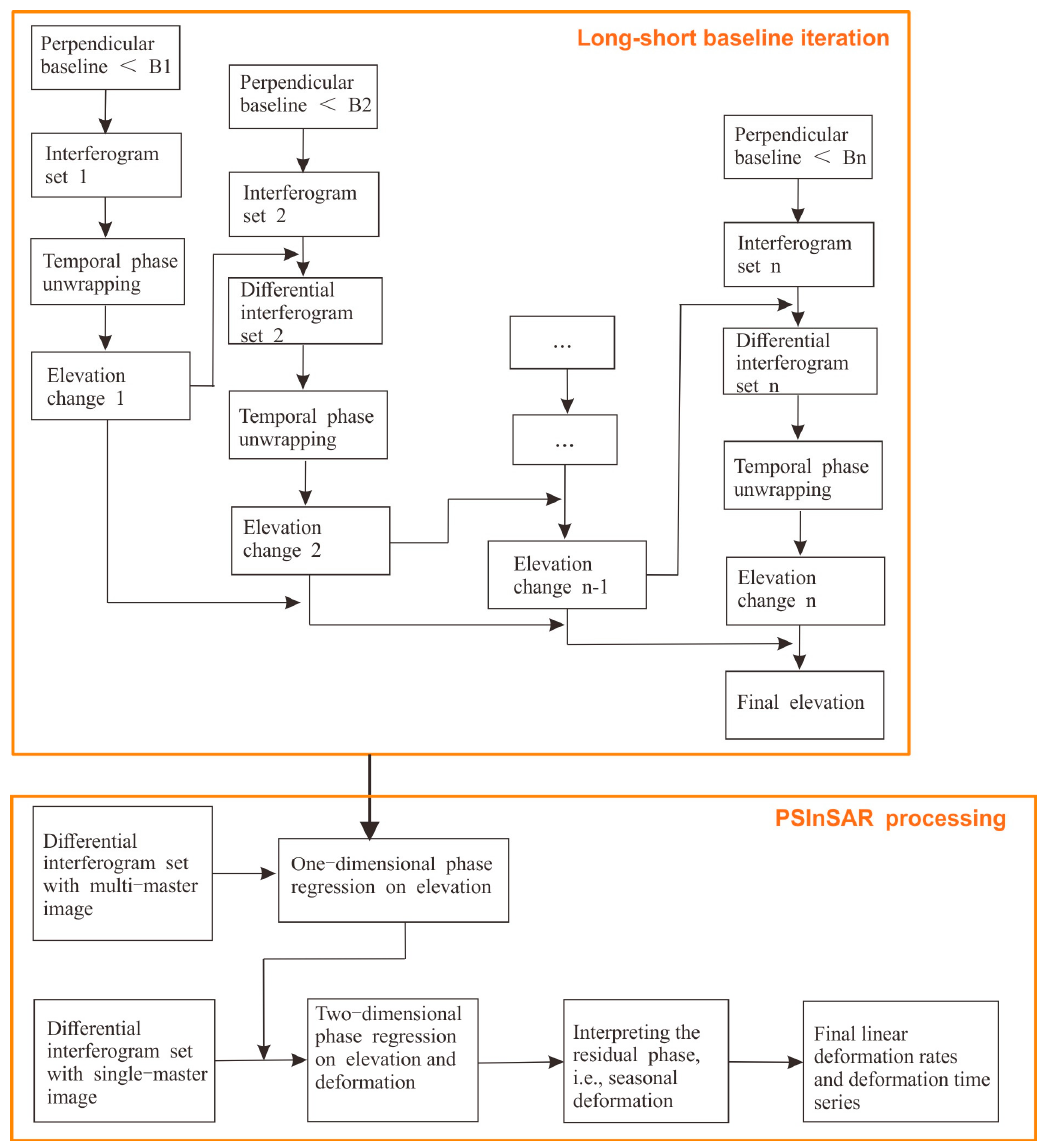
Figure 2. Workflow of the proposed InSAR processing method.